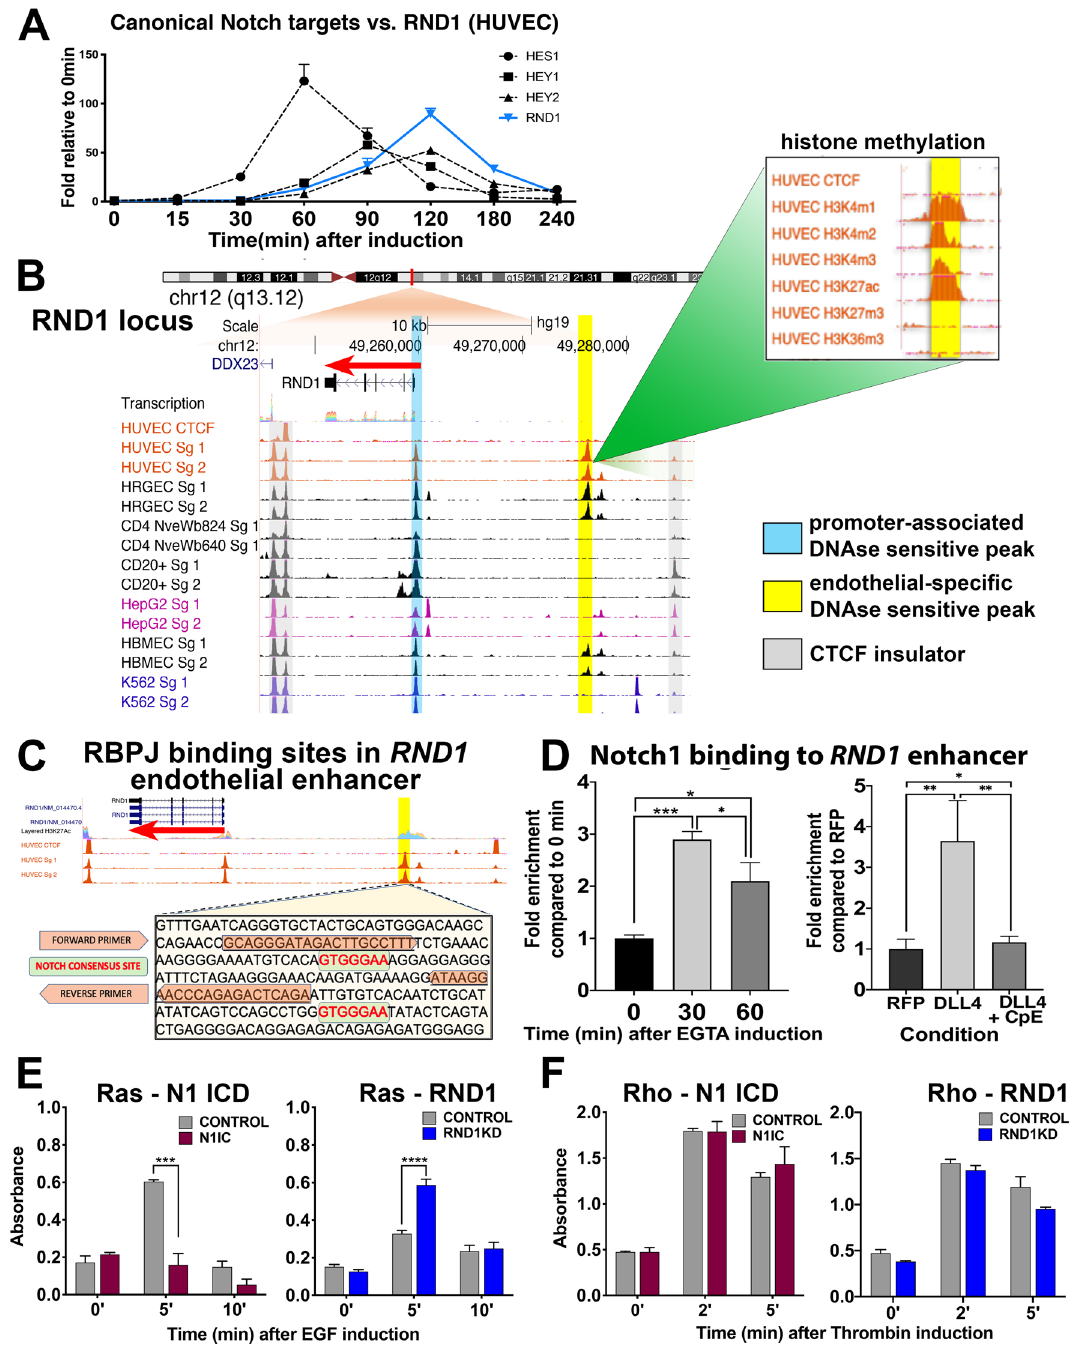
Figure 3. The RND1 locus contains an active endothelial specific enhancer with Notch binding sites. ( A ) RND1 is induced by EGTA at similar rates and magnitude as well-characterized HES and HEY Notch targets. ( B ) ENCODE database view of the RND1 locus shows a DNAse hypersensitivity peak at the promoter region in all cell types (blue bar) and a second peak upstream that appears only in endothelial cell types (yellow bar). The endothelial-specific peak shows histone methylation patterns consistent with active enhancers (insert box). Gray bars mark CTCF-binding insulator regions. ( C ) Enhancer region sequence in the RND1 locus with two Notch consensus sequence (green highlight). Also highlighted is the primer sequence for ChIP PCR (orange highlight). ( D ) ChIP assay of the putative endothelial-specific RND1 enhancer with antibodies against the intracellular domain of Notch1 (N1ICD). N1ICD binds to the RND1 enhancer after EGTA induction (left) or DLL4 overexpression, but binding is blocked with CpE treatment, indicating that active Notch signaling is required. ( E ) HUVECs transfected with siCon or siRND1 or infected with Control or Notch1IC lentiviral constructs were serum-starved for 3 h, treated with 100 ng/ml EGF, and analyzed for Ras activity by G-LISA after 0, 5, and 10 min. ( F ) HUVECs as in (E) were treated with 50 nM thrombin and analyzed for RhoA activity by G-LISA after 0, 2, and 5